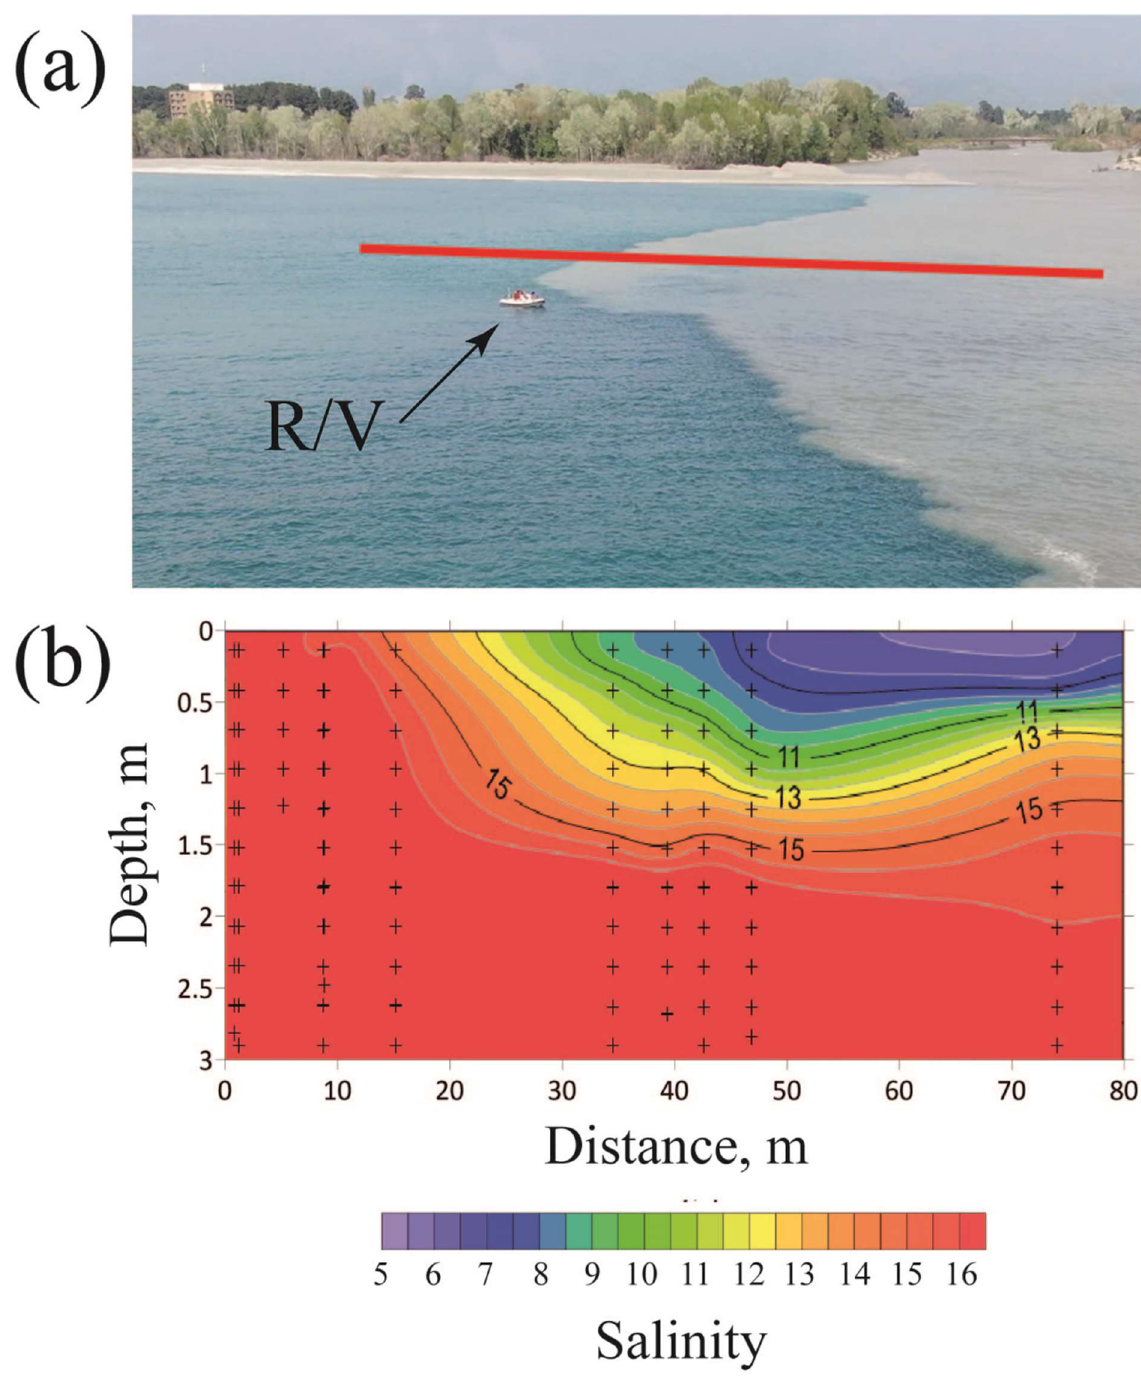
Figure 4. Sharp near-field plume border visible at: ( a ) aerial image of the Bzyb plume border and ( b ) salinity structure across the Bzyb plume border on 27 April 2022. Red line in panel ( a ) indicates location of the cross-border transect. Black crosses in panel ( b ) indicate points of in situ measure- ments.